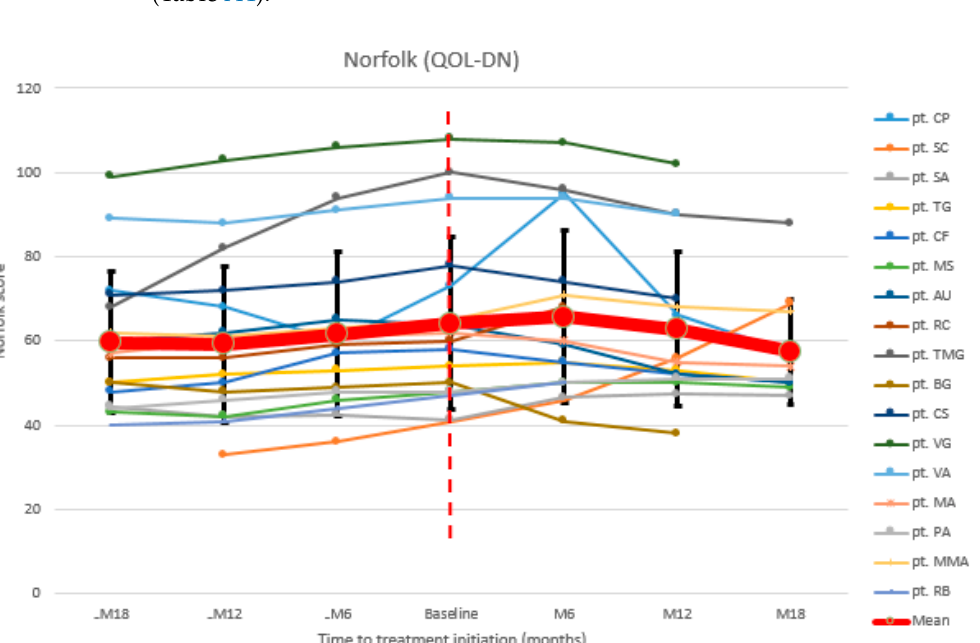
Figure 3. Norfolk QOL-DN: Norfolk quality of life diabetic neuropathy.